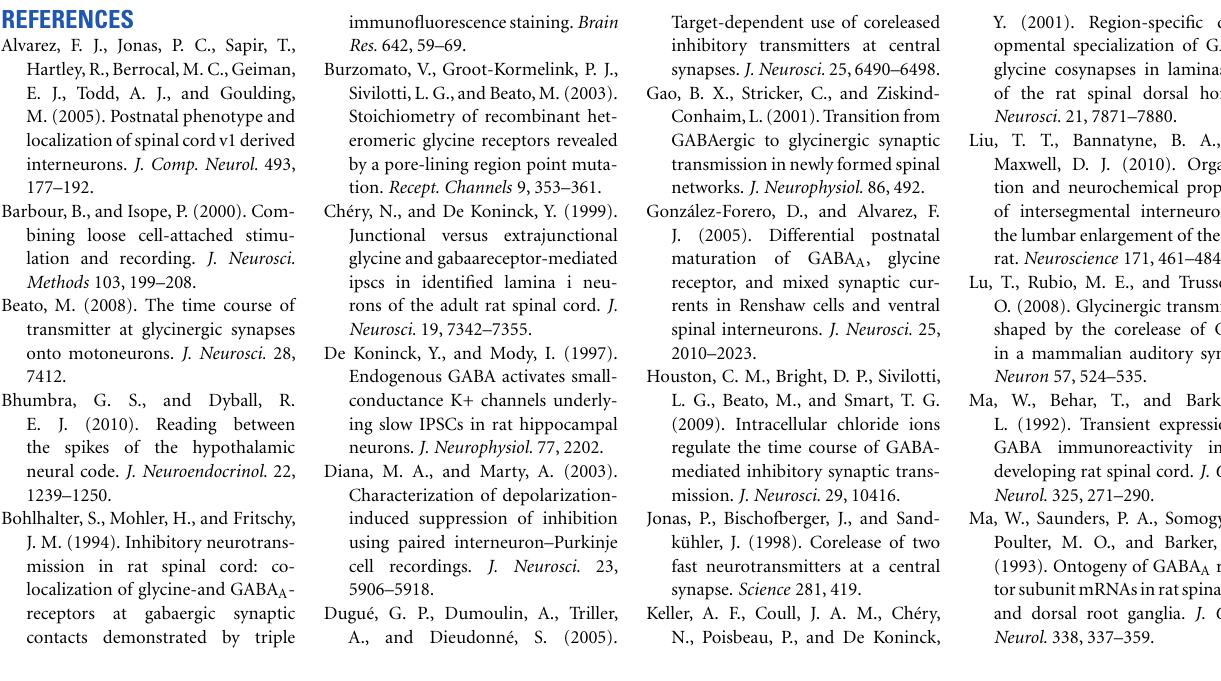
FIGURE 8 | Loading the pre-synaptic cell with 20mM glycine during paired recordings resulted in no progressive changes in post-synaptic responses. Traces in (A) illustrate an example of interneuronal spikes and motoneuronal responses for the first 5 and 45min after rupturing the